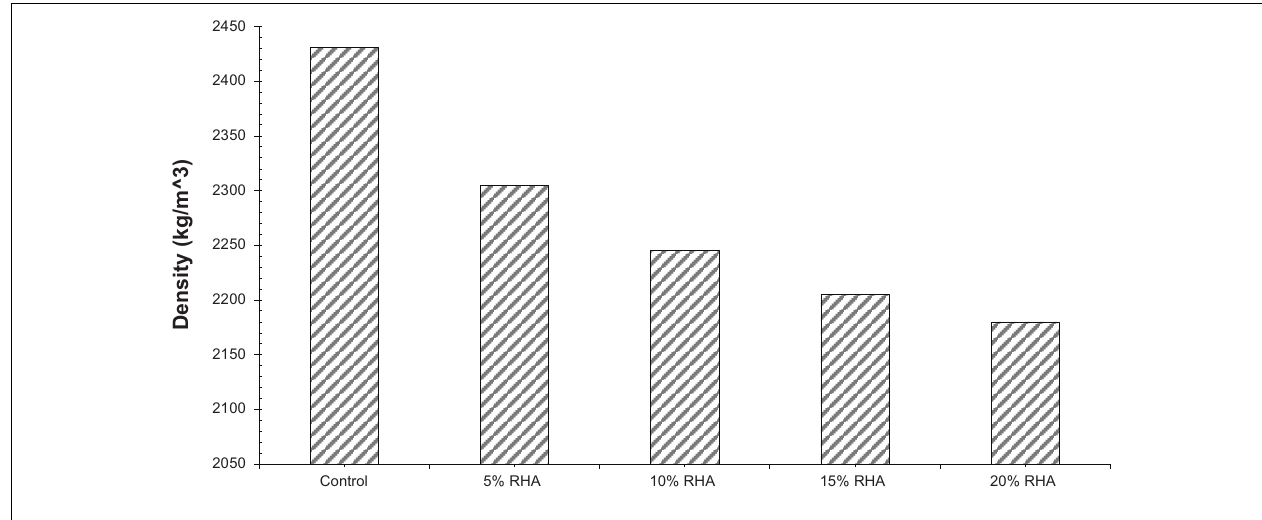
FIGURE 12 | Density (without steel fibers and superplasticizer).